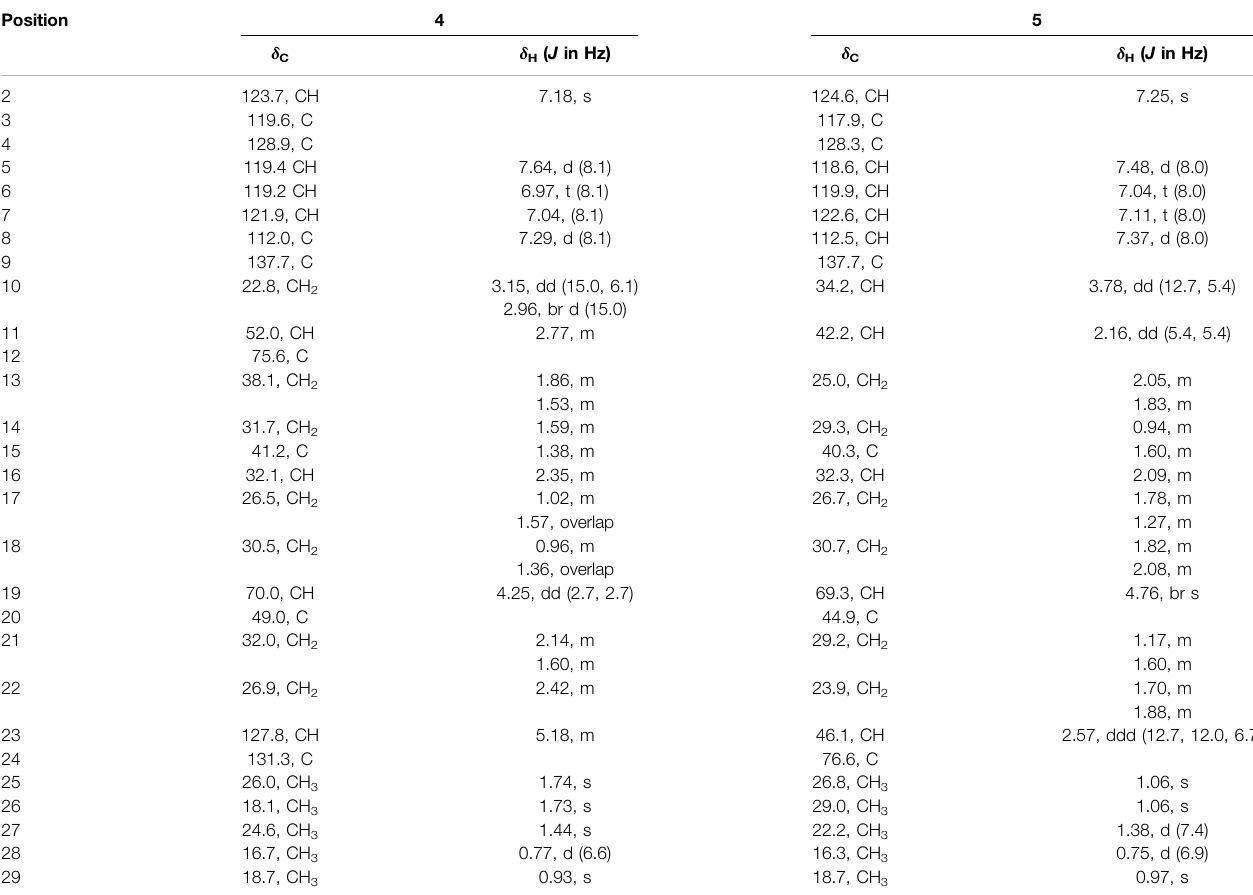
TABLE 2 | The 1 H (400 MHz) and 13 C NMR (100 MHz) data of compounds 4 and 5 in CD 3 OD.